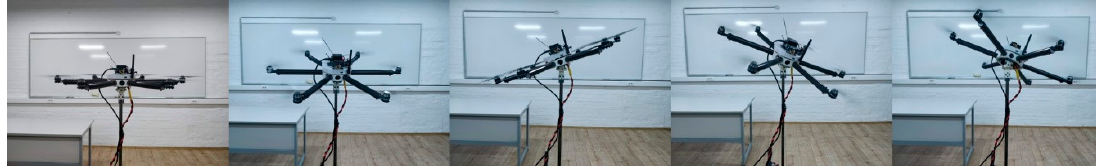
Figure 19. Experimental testing of attitude control on flat hexarotor configuration (FX6).